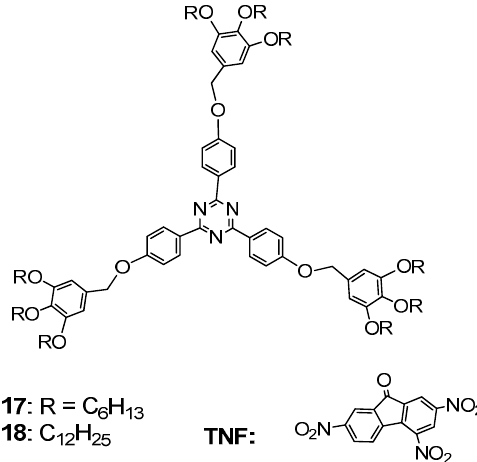
Figure 11. Structures of dendrimers ( 17 ) and ( 18 ).